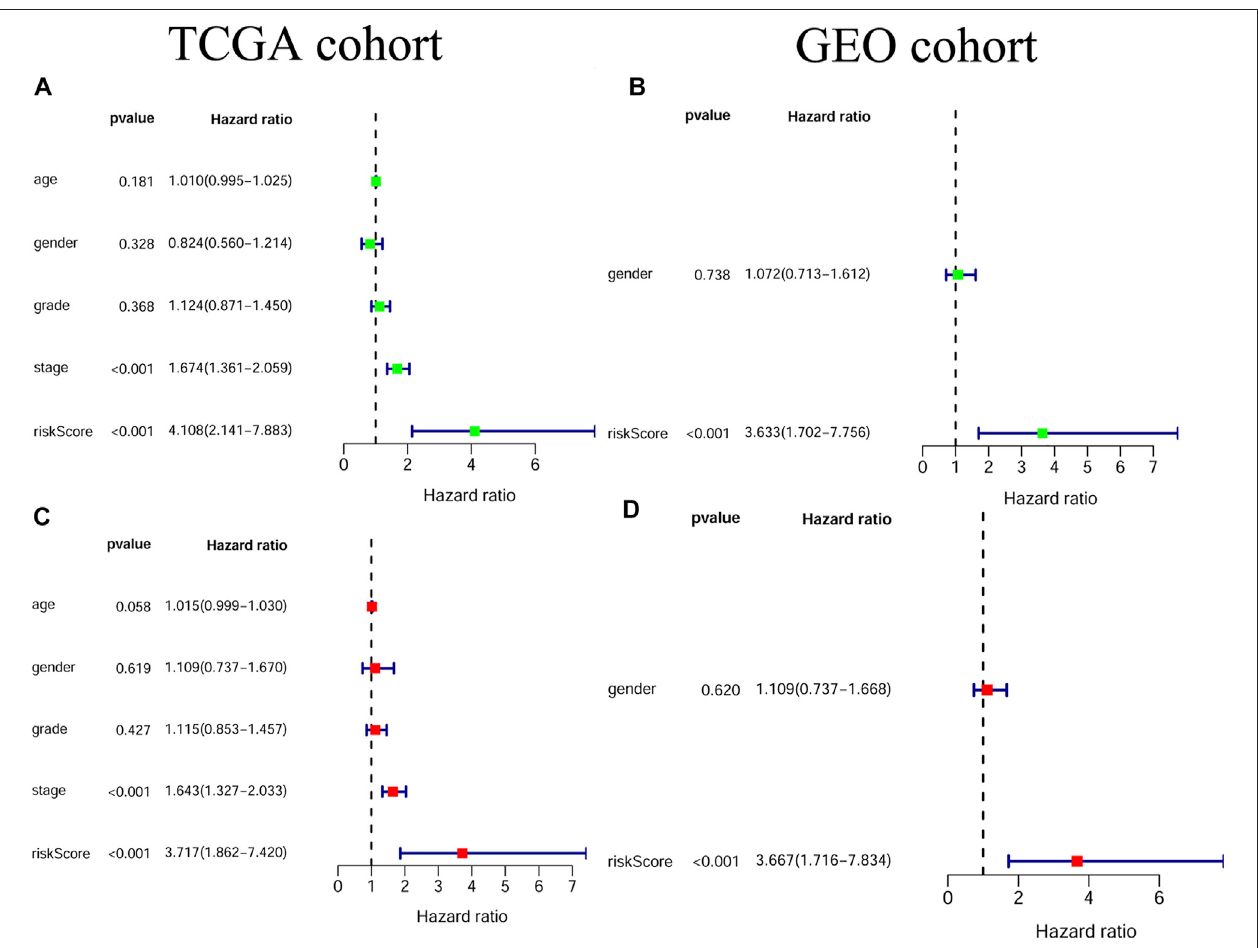
FIGURE5| Theindependentprognosticvalueoftheriskscore (A) UnivariatecoxregressionanalysisfortheTCGAcohort (B) Univariatecoxregressionanalysisfor the GEO cohort (C) Multivariate cox regression analysis for the TCGA cohort (D) Multivariate cox regression analysis for the GEO cohort.